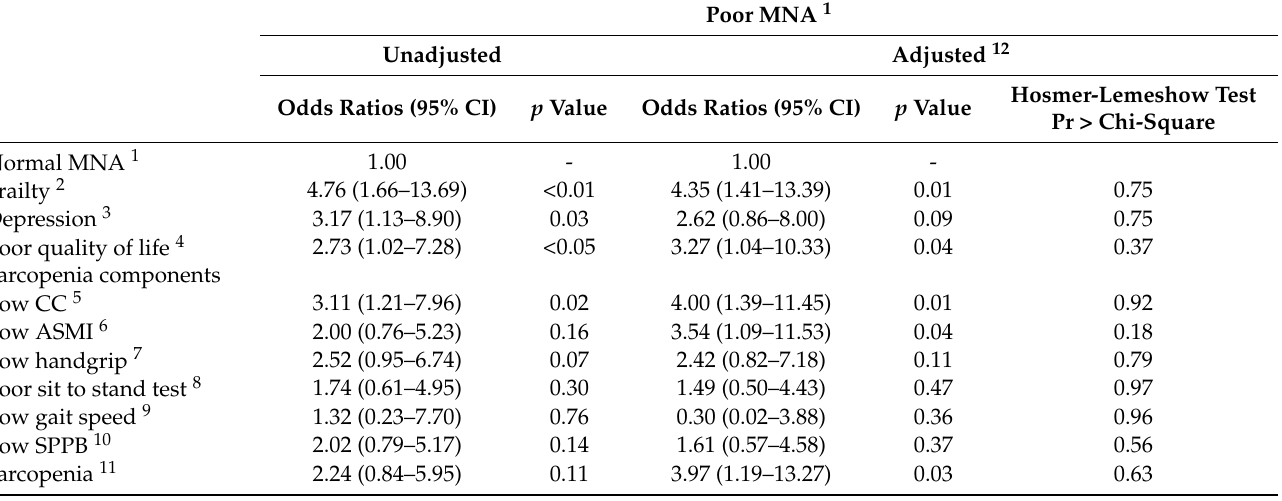
Table 4. Associations between nutritional status and frailty, depression, quality of life, and sarcopenia. Poor MNA